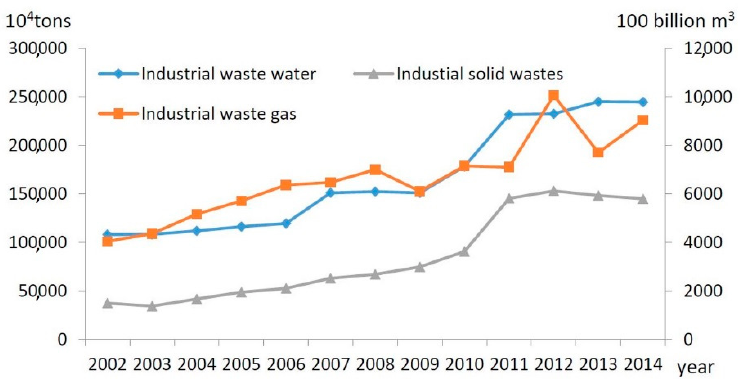
Figure 1. Industrial sales value of mining industrial over 2001–2014.